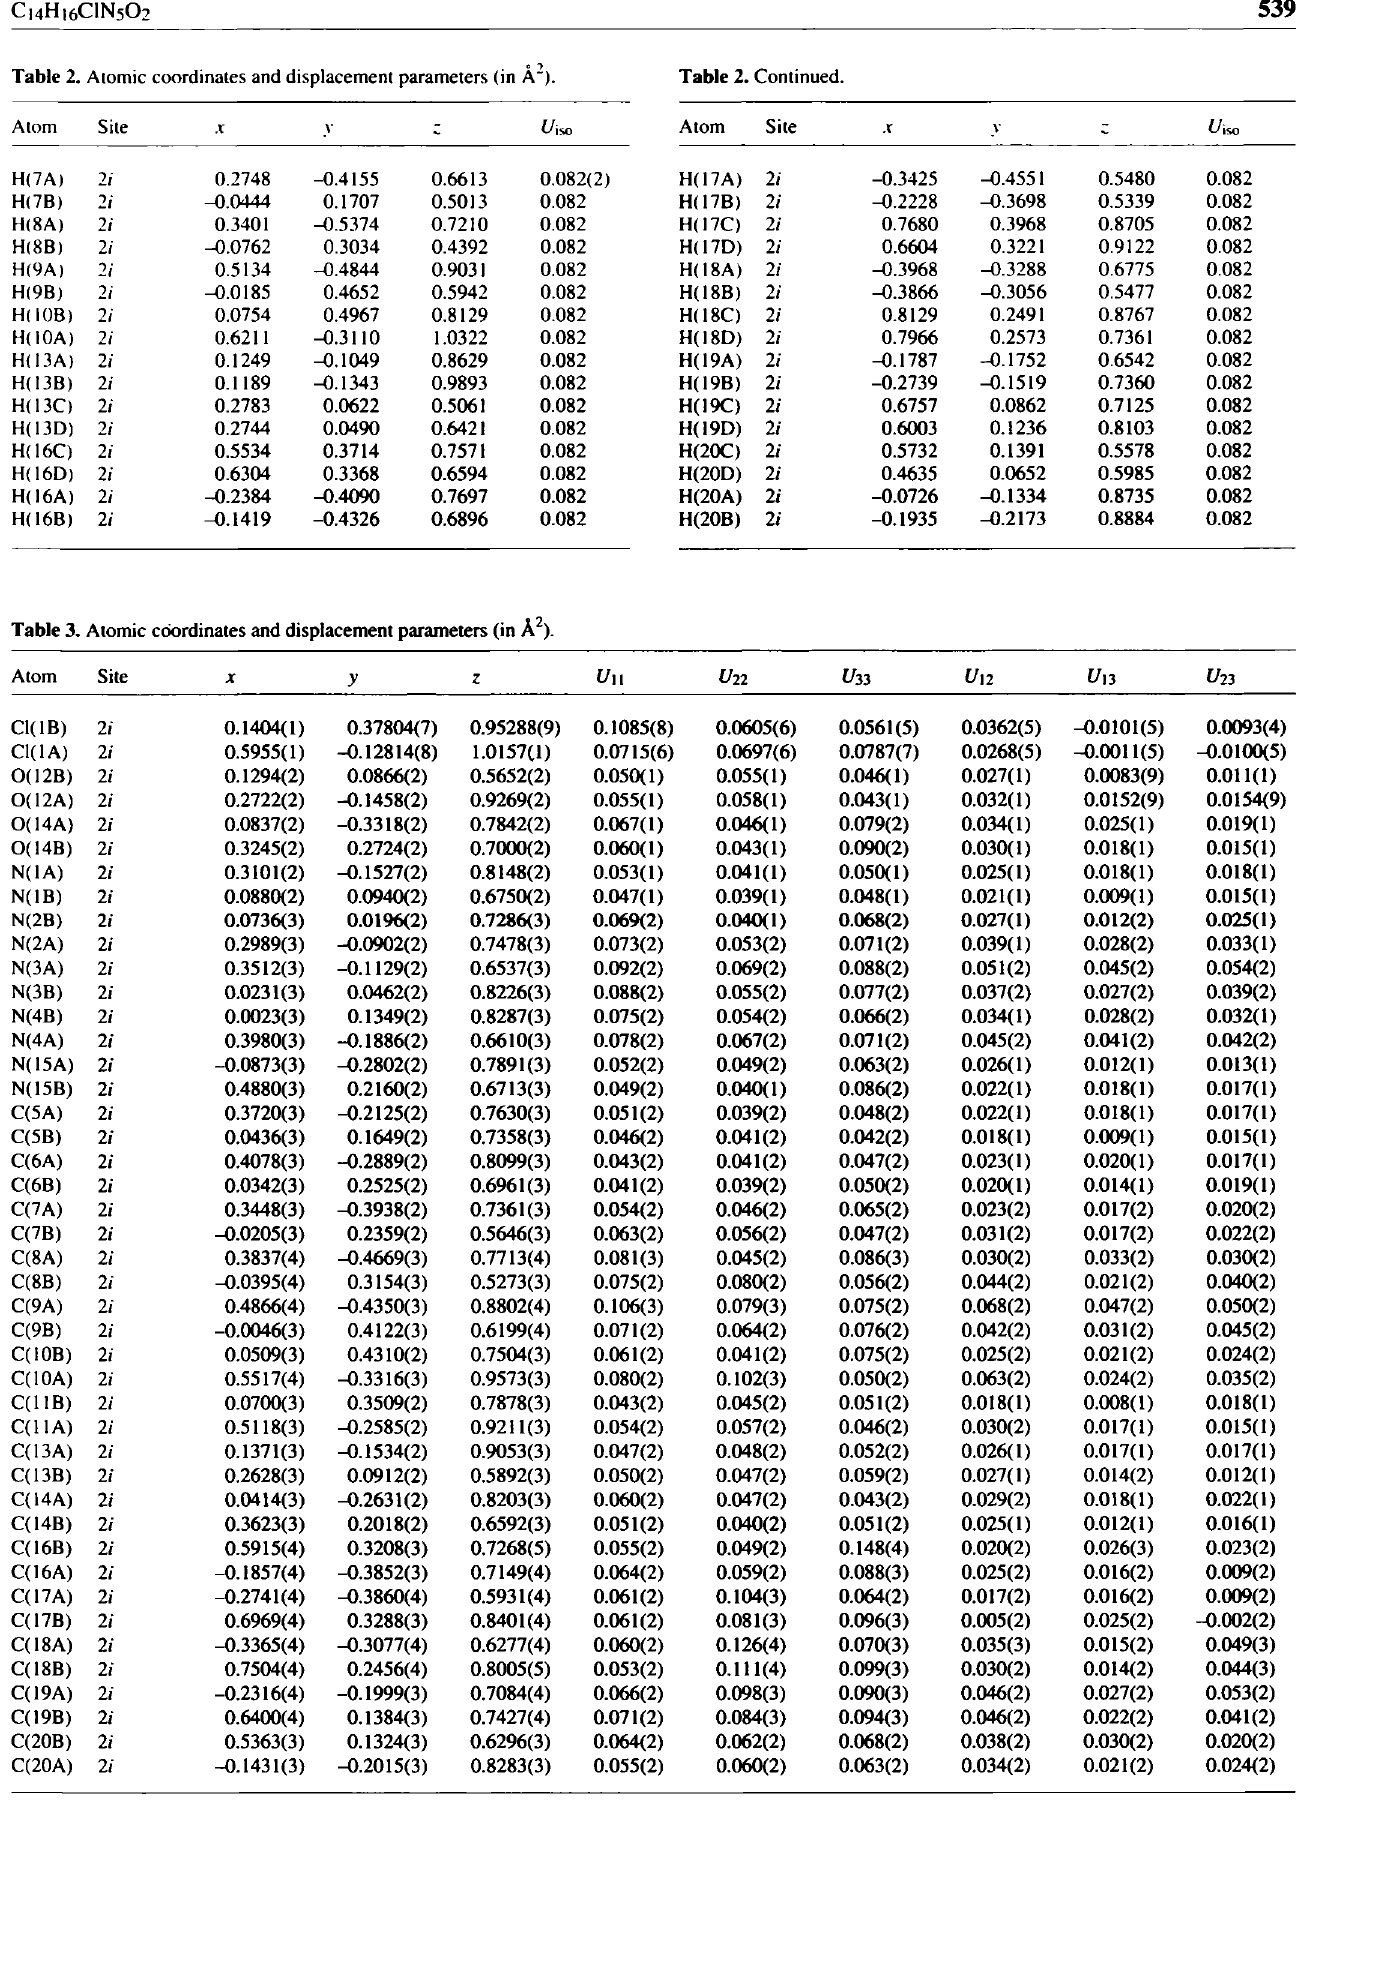
Table 2. Atomic coordinates and displacement parameters (in A 2 ).